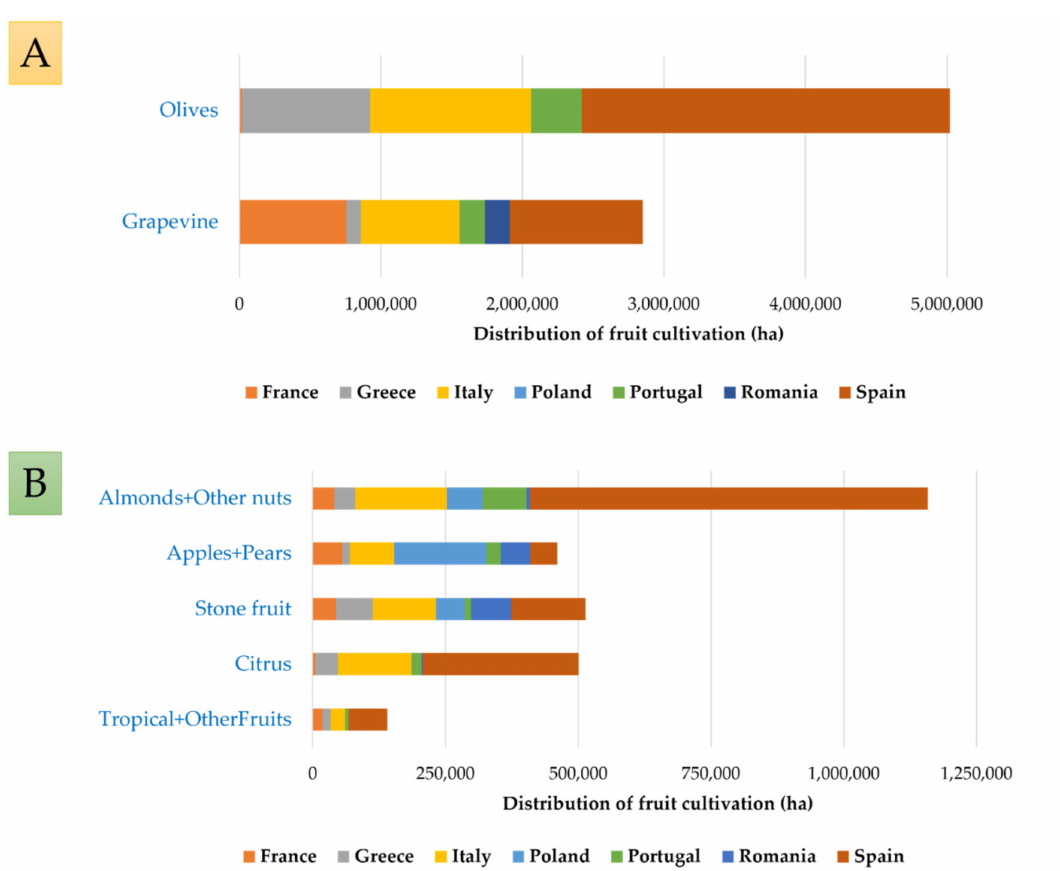
Figure 2. ( A ) Distribution of olive trees and grapevines and, ( B ) nut trees, apple and pear trees, stone fruit trees, citrus fruit trees, and other trees by European countries